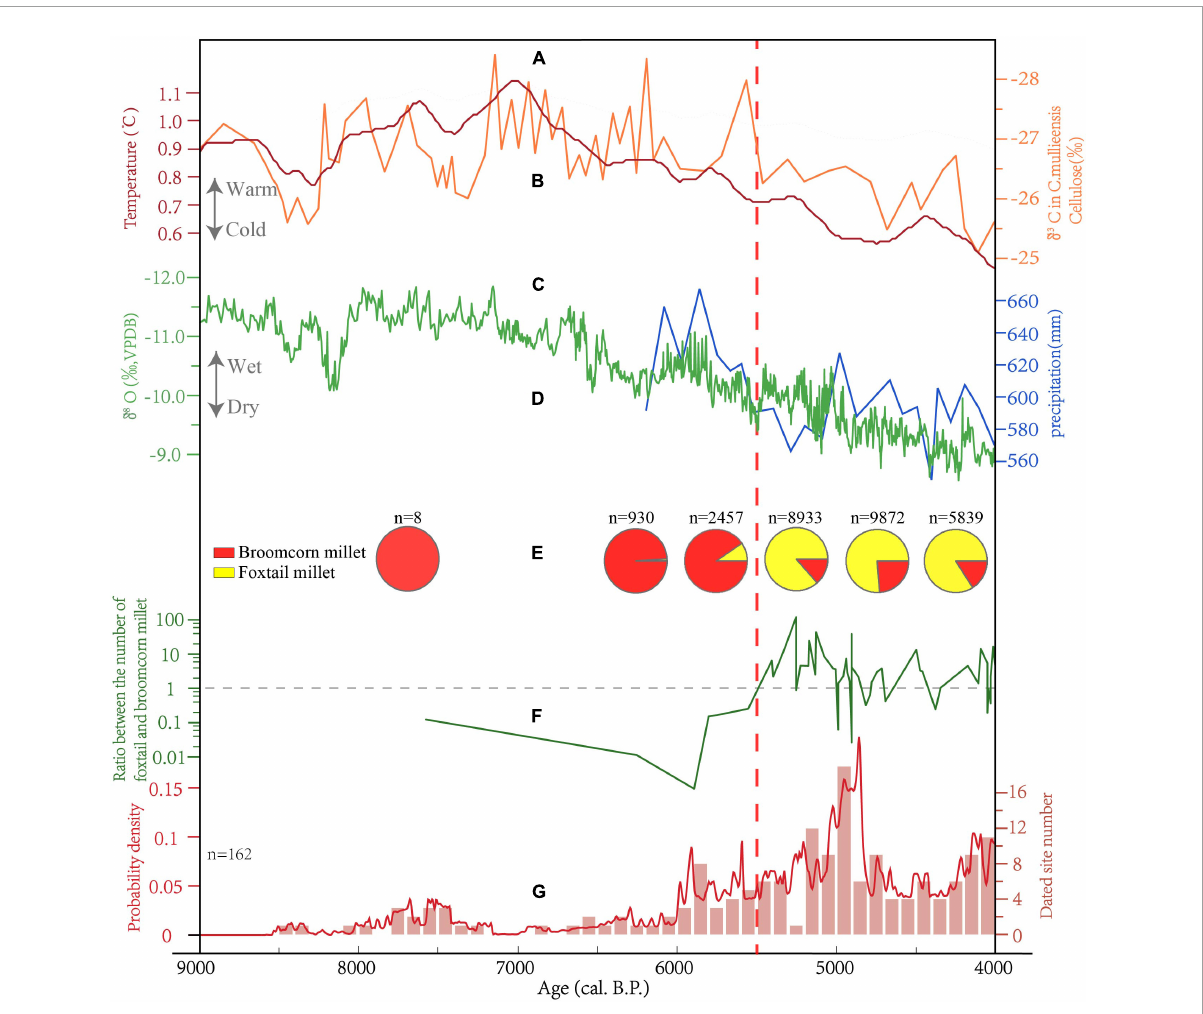
FIGURE6 Comparison of human activity intensity, climate change and millet ratio in the WLP from 9,000–4,000 BP. (A) δ 13 C record of a single plant in Hongyuan peat bog (Hong et al., 2003). (B) Northern Hemisphere (30 ◦ ∼ 90 ◦ N) temperature record (Marcott et al., 2013). (C) Reconstructed precipitation based on fossil pollen at Tianchi Lake (Zhao et al., 2010). (D) Stalagmite δ 18 O record at Wuya Cave (Tan et al., 2020). (E) Proportions of broomcorn millet and foxtail millet in the WLP between 9,000–4,000 BP at different periods. (F) Absolute number proportions of foxtail millet to broomcorn millet identified from sites dated between 9,000–4,000 BP in the WLP. (G) The Summed Probability Distribution (SPD) of averaged dates of bins (The line chart) and the dated site number (The column chart) in the